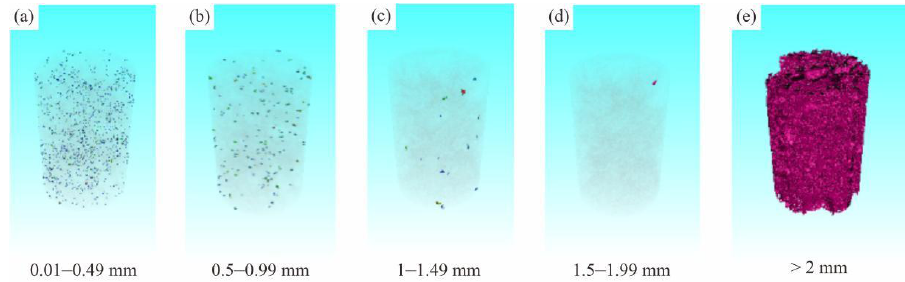
Figure 12. Distribution map of pore gradient with different diameters. ( a ) Distribution map of pore gradient in the range of 0.01–0.49 mm. ( b ) Distribution map of pore gradient in the range of 0.5–0.99 mm. ( c ) Distribution map of pore gradient in the range of 1–1.49 mm. ( d ) Distribution map of pore gradient in the range of 1.5–1.99 mm. ( e ) Distribution map of pore gradient more than 2